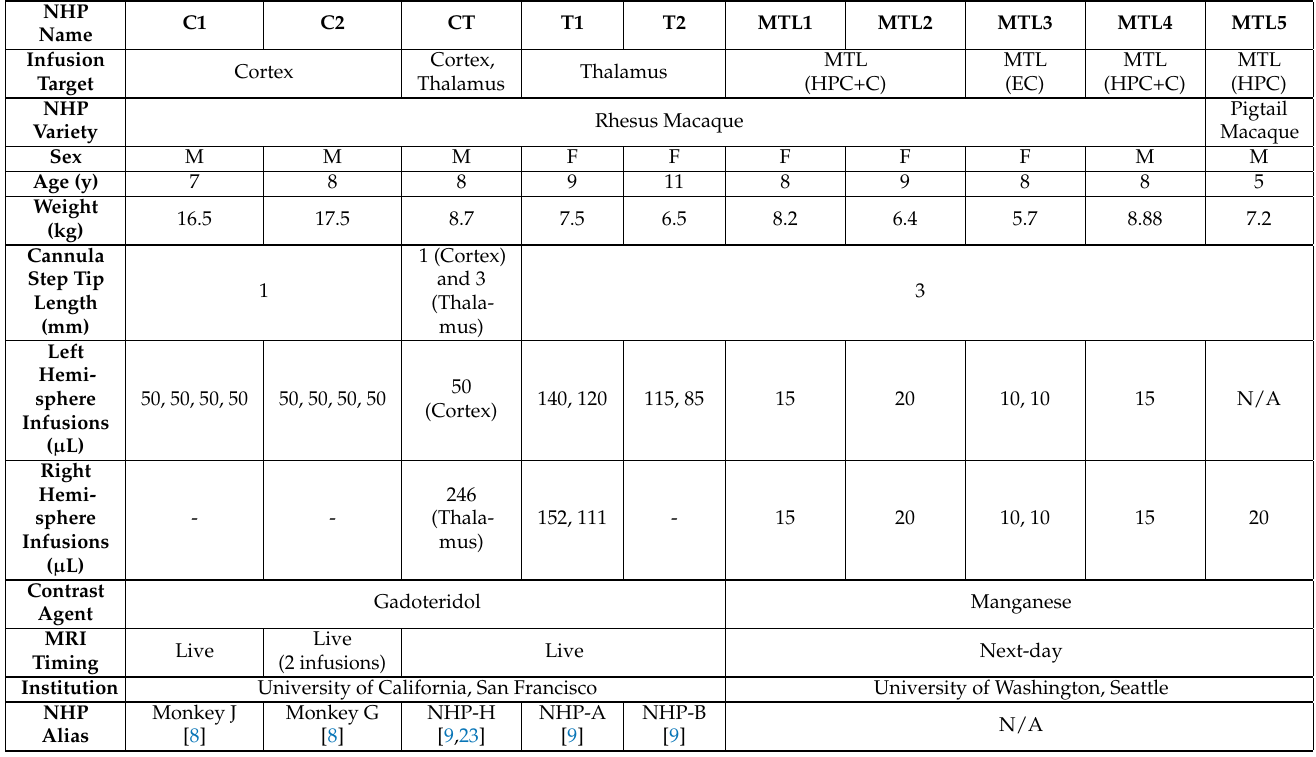
Table 1. NHP and surgical data. NHPs are named for their infusion location(s). Medial temporal lobe and caudate nucleus (MTL). Hippocampus (HPC). Entorhinal cortex (EC), Tail of Caudate Nucleus